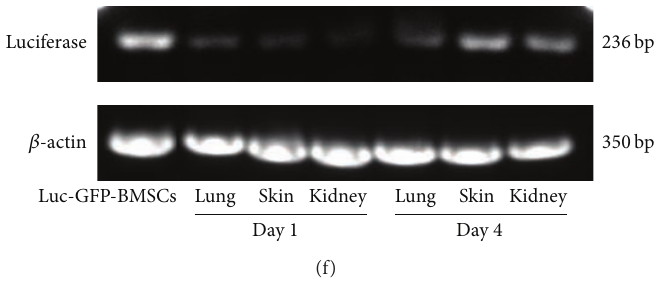
Figure 3: Distribution of the transplanted Luc-GFP-BMSCs within different organs. (a) BLI signals were diffusely distributed on the back in vivo at 4 days after injection. (b) IVIS photographs of dissected lungs (1), hearts (2), spleens (3), vertebral columns (4), intestines (5), livers (6), kidneys (7), and the skin of the lower back (8), showing direct confirmation of bioluminescence activity; Luc-GFP-BMSCs were localized to the kidneys, lungs, and the skin of the lower back ( 𝑛 = 5 ). (c) Immunohistochemically stained kidneys, lungs, and skin collected at 1 day as well as 4 days after injection. The specific position and positive cell counts were determined. (d and e) Positively stained cells in the lungs, kidneys, and skin were counted, and the migration of BMSCs appeared to be tissue associated over time. 𝑛 = 5 , and ∗ presents 𝑃 < 0.01 . (f) The expression of the firefly luciferase gene was detected via RT-PCR. 𝛽 -actin was used as a loading control. Target gene expression was found in the lungs, kidneys, and skin of animals at 1 day as well as 4 days after injection. Representative images of at least three independent